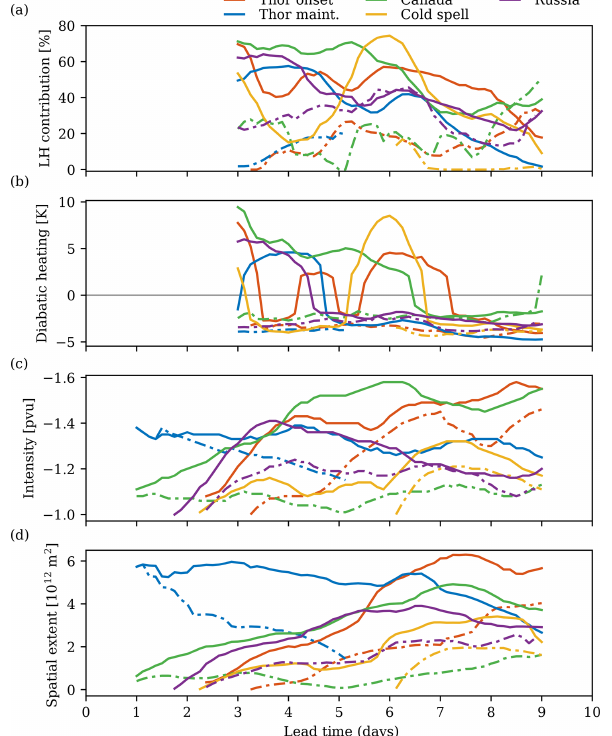
Figure 10. (a) Percentage of blocking trajectories with (cid:49)θ > 2K in 3d (%), (b) mean diabatic heating (K, calculated as the mean change in θ along all (heated and non-heated) trajectories), (c) blocking intensity (upper-level PV anomaly), and (d) spatial ex- tent (10 12 m 2 ) as a function of simulation lead time. Solid lines show CNTRL simulations, and dashed lines show NOLH simula- tions. Note that the individual curves start as soon as a block is identified with the PV-anomaly index, and 3d backward trajecto- ries can only be calculated after day 3.